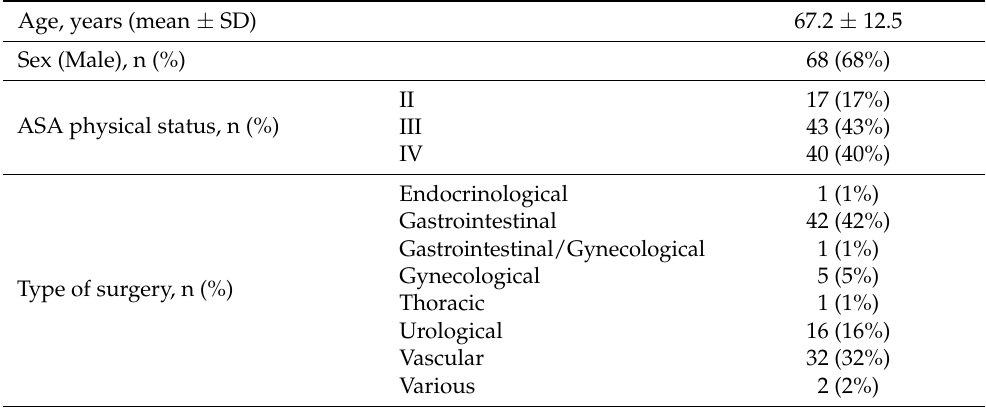
Table 1. Demographic and clinical characteristics of patients undergoing major non-cardiac